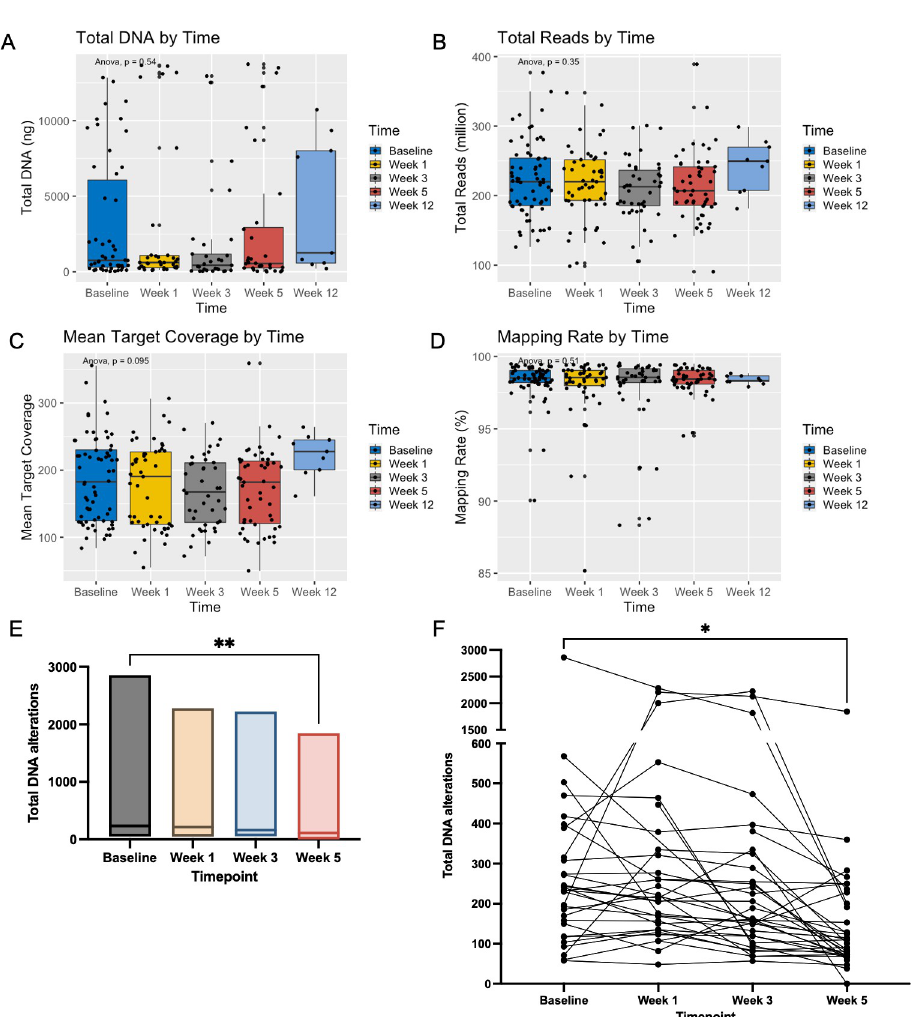
Fig 3. Quality Characteristics and DNA alterations for all Samples by Time (A) Total DNA yield did not differ by acquisition timepoint. Total reads (B), mean target coverage (C) and mapping rate (D) did not differ by timepoint. Number of DNA alterations at baseline decreased at week 5 of CRT in all patients (E, p = 0.008) as well as when 33 patients with samples at all 4 time points were examined (F, p =